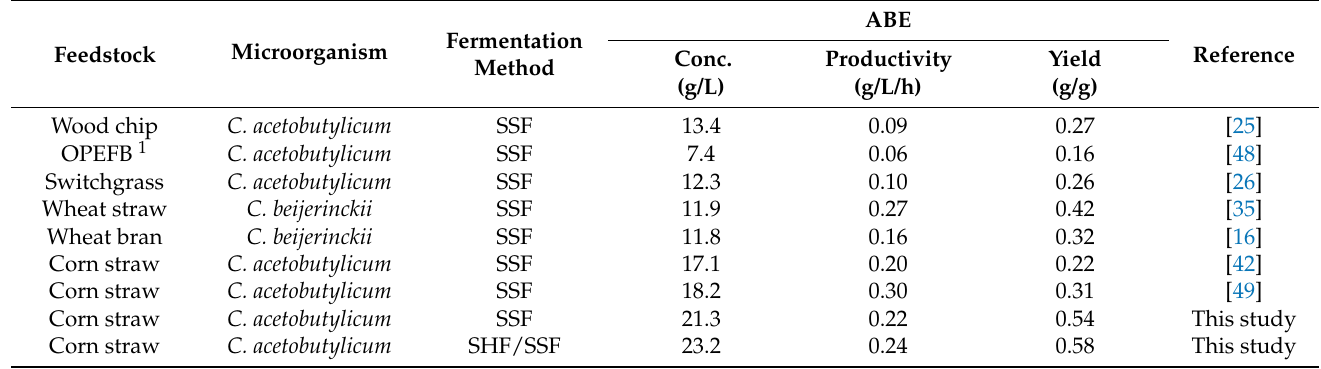
Table 2. Comparative performance of ABE fermentation via SSF